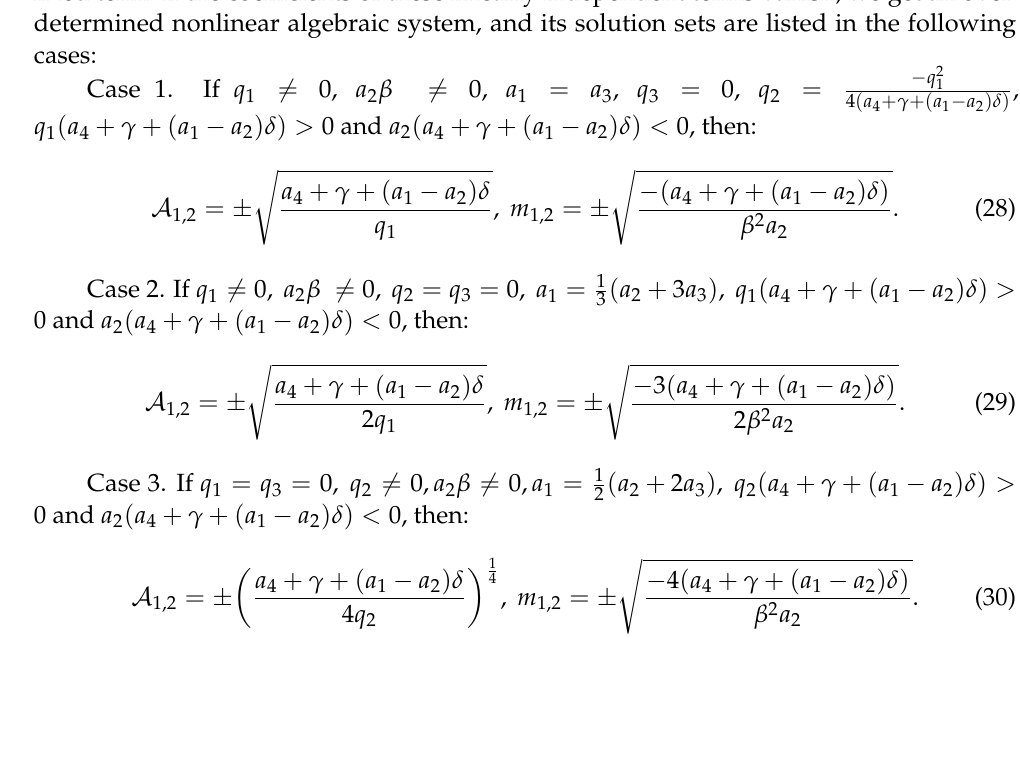
Figure 7. Variation of the inferred bright soliton solution (26), | ψ 2 ( x , t ) | , where m = − A (1): ( a ) with the group velocity dispersion parameter 𝑎 1 where: 𝐴 = ℬ = 𝑎 (cid:2869) = 1,𝑞 (cid:2870) = 1.8,𝑞 (cid:2871) = 1.3,𝛾 = 0.5,𝑎 (cid:2872) = 0 and 𝑡 = 5 ; ( b ) detuning effect parameter 𝑎 0.8,𝑞 (cid:2871) = 1.3,𝛾 = 0.5, 𝑎 (cid:2872) = 0 and 𝑡 = 1 .